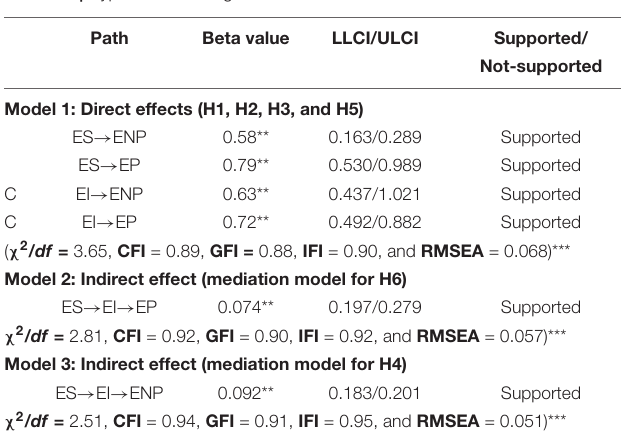
TABLE 3 | Hypotheses testing.